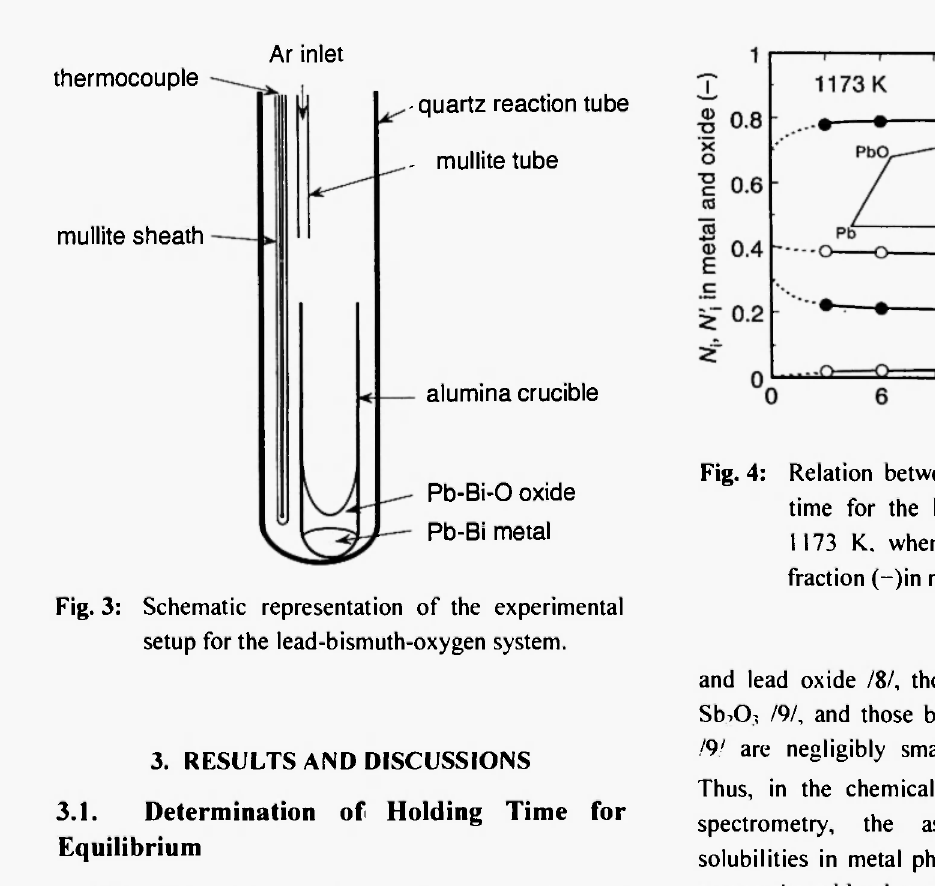
Fig. 3: Schematic representation of the experimental setup for the lead-bismuth-oxygen system.